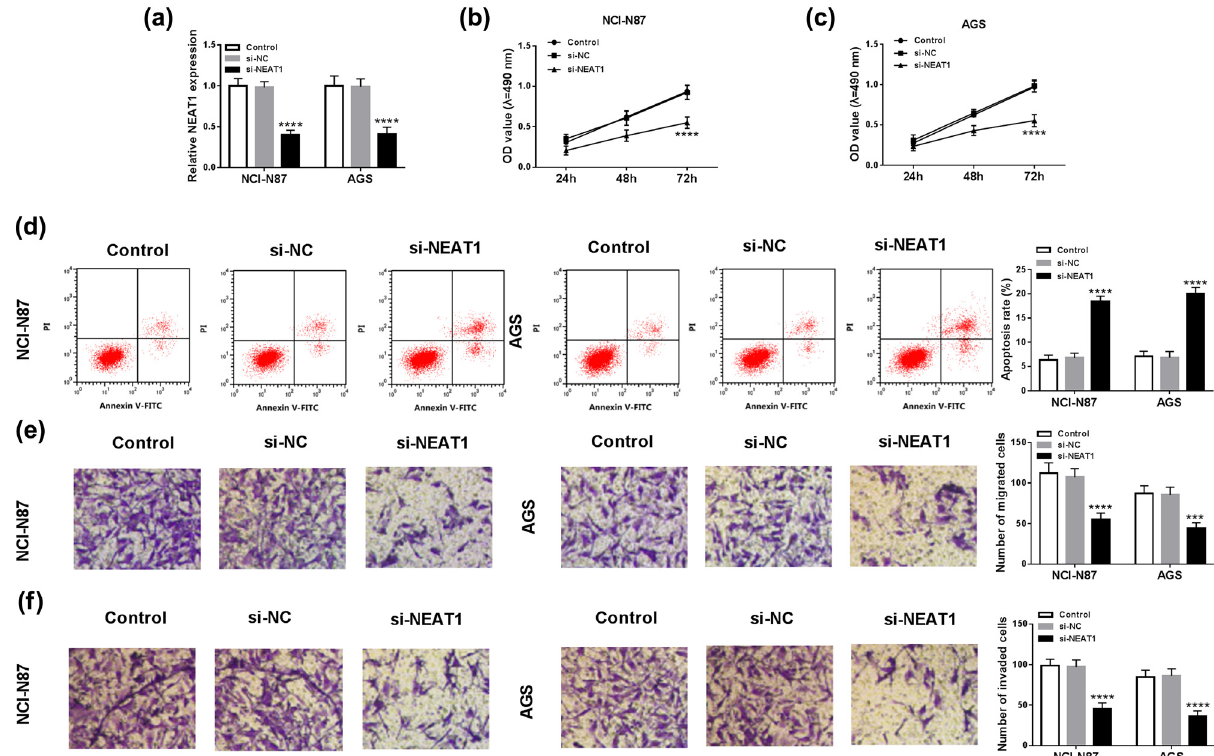
Figure 2: Knockdown of NEAT1 suppressed cell proliferation and metastasis, but motivated apoptosis in GC cells. ( a ) The knockdown e ff ect of si - NEAT1 was assessed by qRT - PCR. ( b and c ) Cell proliferation was detected by MTT assay in NCI - N87 and AGS cells transfected with si - NEAT1. ( d ) Cell apoptosis was determined by fl ow cytometry. ( e and f ) Cell migration and invasion were examined by transwell assay. *** P < 0.001, **** P <